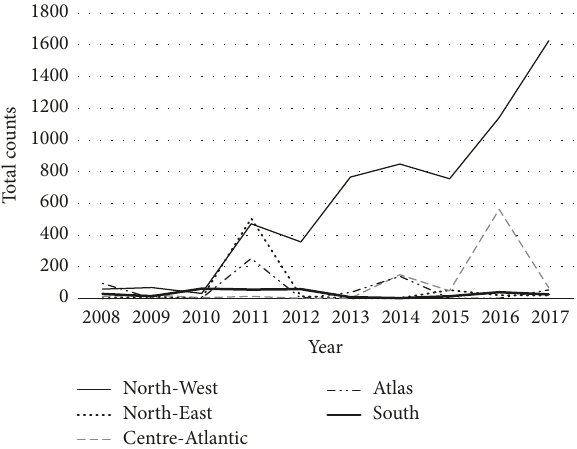
Figure 2: Linear trend of the Ferruginous duck’s wintering popula- tion (TRIM analysis). Figure 3: Evolution of the Ferruginous duck’s total numbers by region during the last